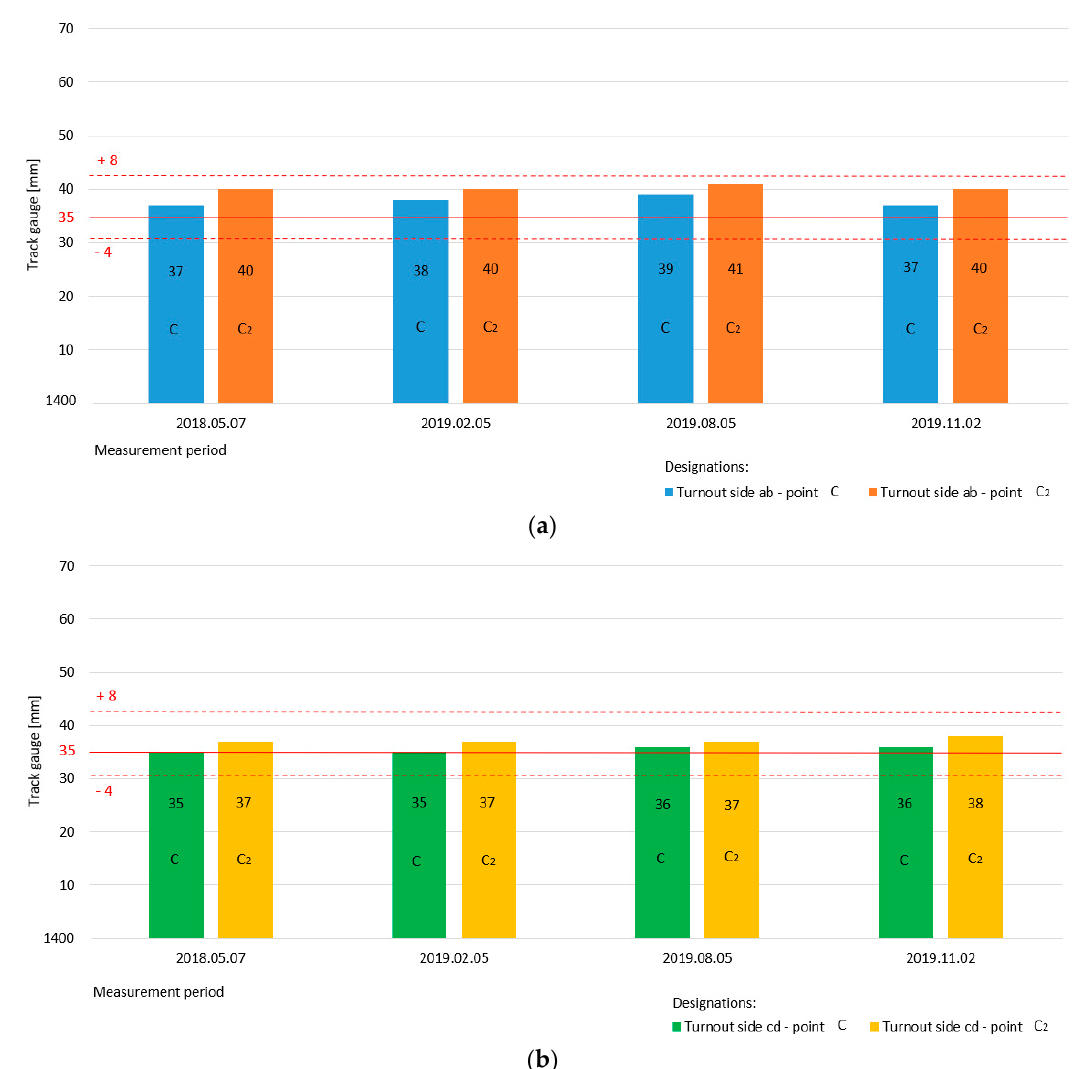
Figure 11. The track gauge of the main track for turnout number 9: ( a ) turnout side “ab” (measurement at c, c 2 ); ( b ) turnout side “cd” (measurement at c, c 2 ).